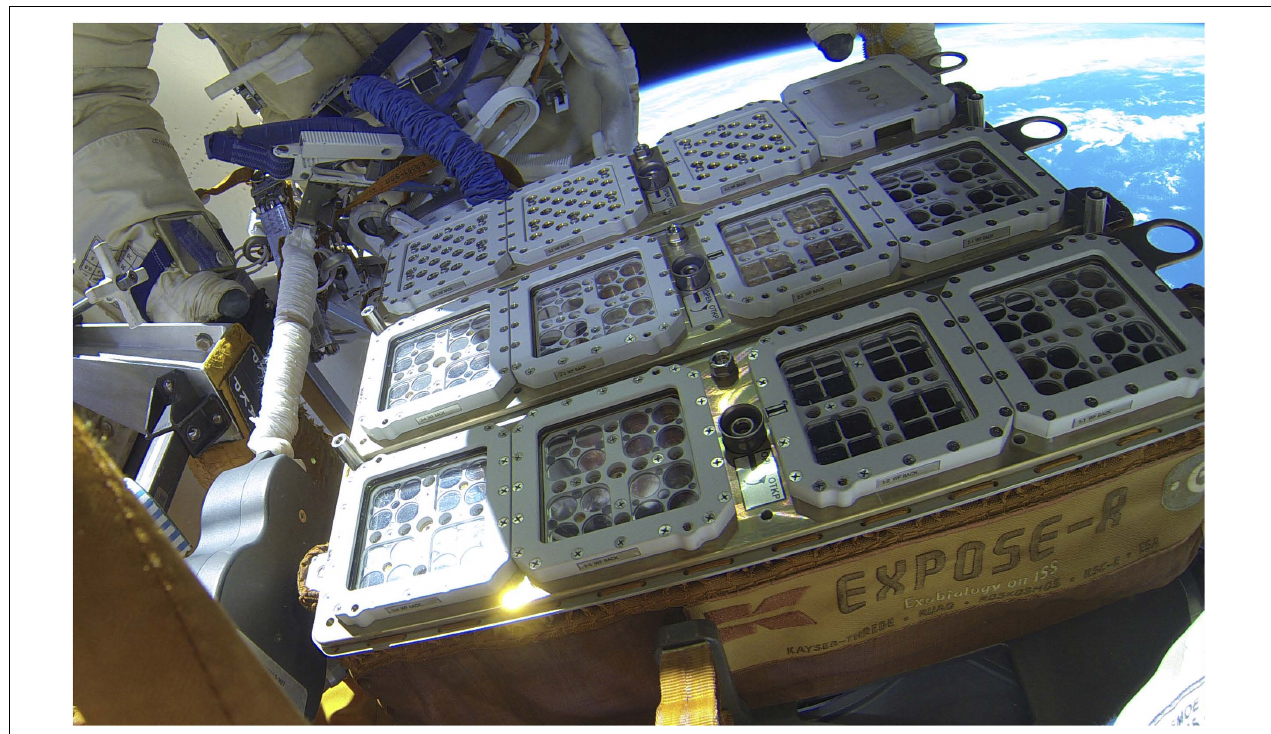
FIGURE 8 | EXPOSE-R2 uncovered in space. The EXPOSE-R monoblock was reused but refurbished with three new trays carrying the samples of the EXPOSE-R2 mission. Credit ESA, ROSCOSMOS.